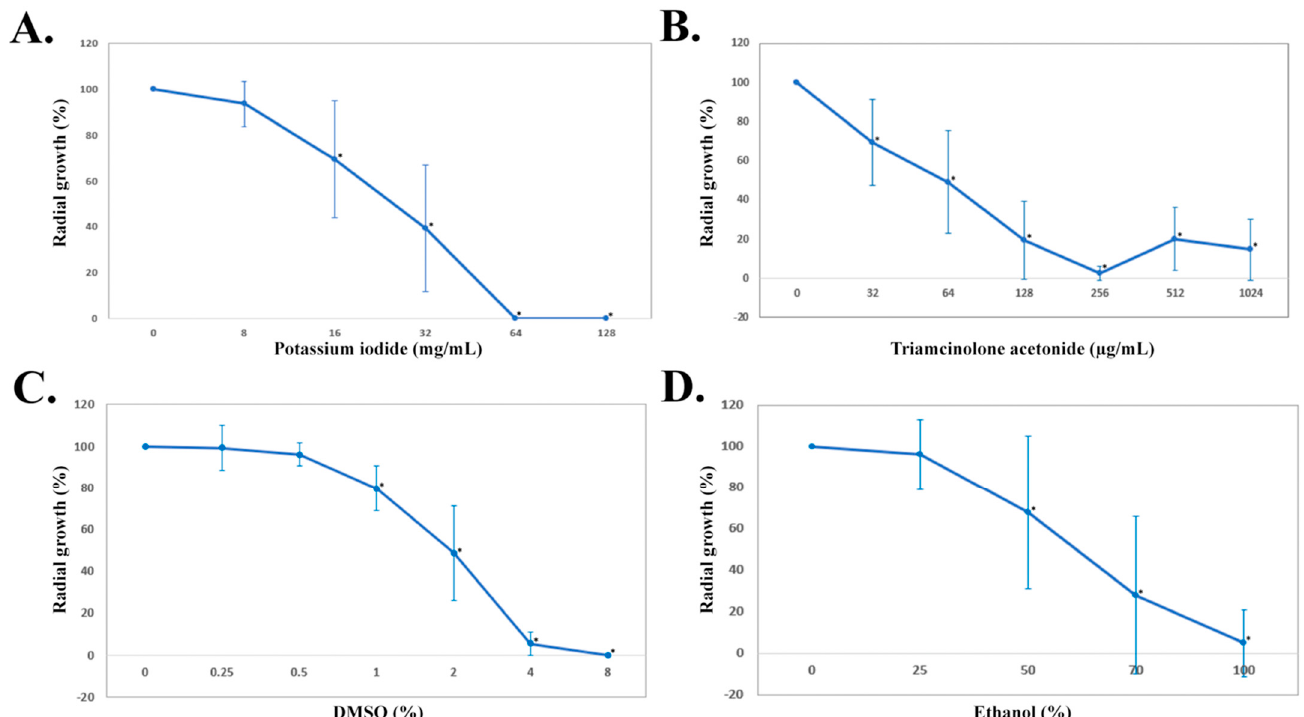
Figure 1. Growth reduction of P. insidiosum after treatment with various concentrations of potassium iodide ( A ), triamcinolone acetonide ( B ), DMSO ( C ), and ethanol ( D ). The radial growths are averaged based on 10 representative isolates of P. insidiosum after 2 − day exposure to potassium iodide, triamcinolone acetonide, and DMSO, and 1 − min exposure to absolute EtOH. An asterisk indicates a statistically significant growth reduction compared to no-drug control.